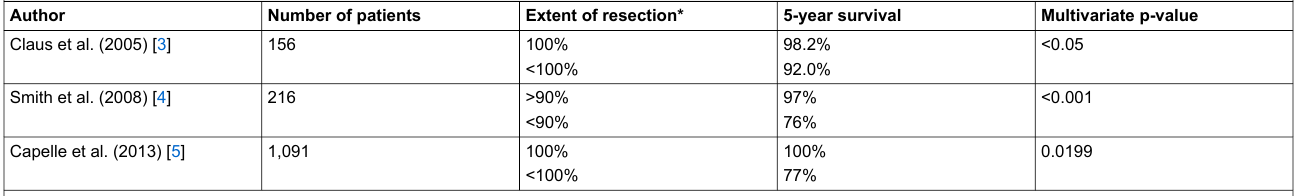
Table 1: Volumetrically assessed EOR in low grade gliomas and its influence on